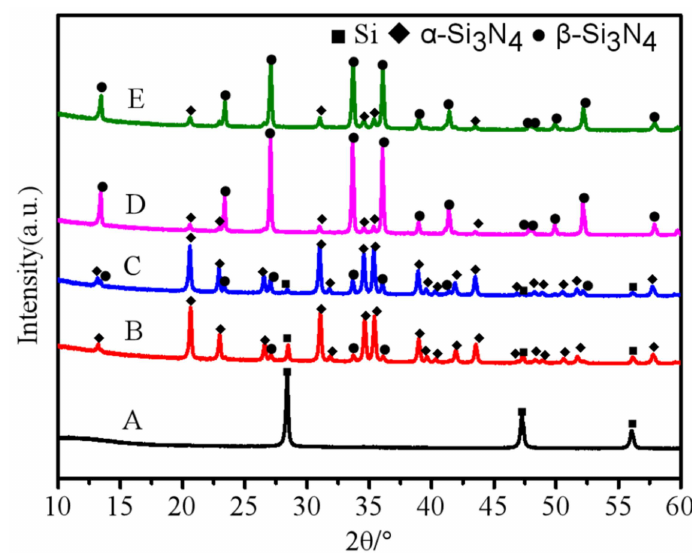
Figure 1. X-ray di ff raction patterns of the products obtained at 1300 ◦ C under NH 3 atmosphere with di ff erent contents of CaF 2 additive (A) 0 wt% CaF 2 ; (B) 1 wt% CaF 2 ; (C) 3 wt% CaF 2 ; (D) 4 wt% CaF 2 ; (E) 7 wt% CaF